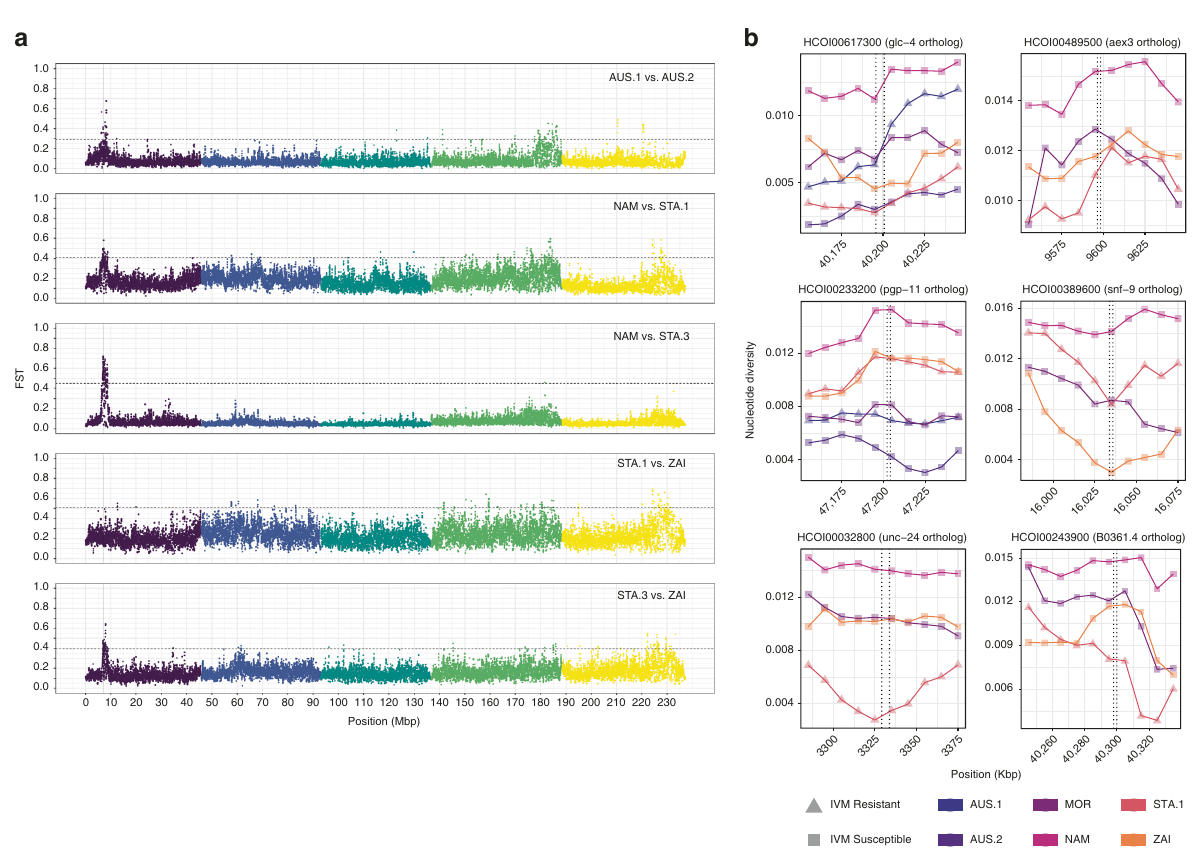
Fig. 5 Looking for ivermectin-associated genes. a Genome-wide differentiation scan for ivermectin resistance. F ST estimates between pairs of ivermectin- resistant (AUS.1, STA.1, STA.3) and isolates with no evidence for ivermectin resistance is plotted along genomic position. Chromosomes are coloured and ordered by name, i.e., from I (purple) to V (yellow). Horizontal line represents the 0.5% F ST quantile cutoff. Vertical line on chromosome I points at Hco- tbb-iso-1 locus. b Nucleotide diversity over candidate genes for ivermectin resistance. A 100-Kbp window surrounding the candidate gene position (highlighted by vertical dashed lines) is shown. Dots represent the mean F ST over a 10-Kbp window. Ivermectin-resistant isolates (IVM-R) appear as triangles and squares indicate susceptible isolates